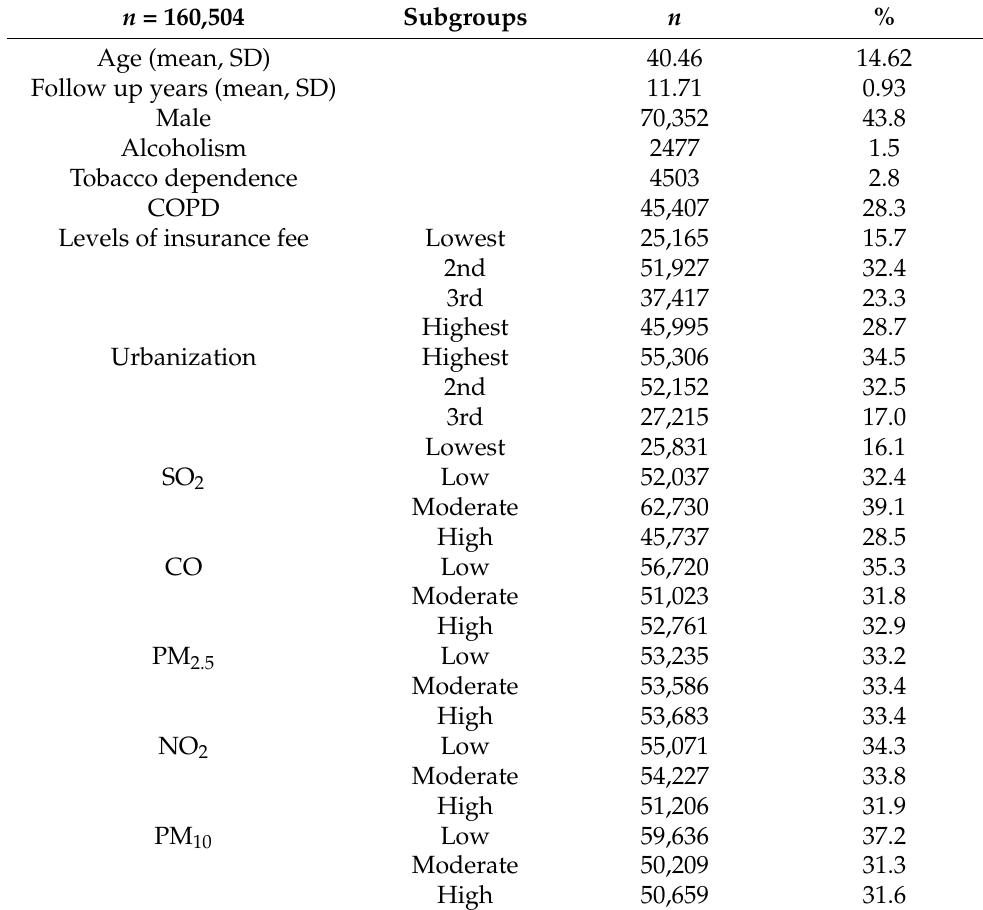
Table 1. The demographic data of the study participants. n =